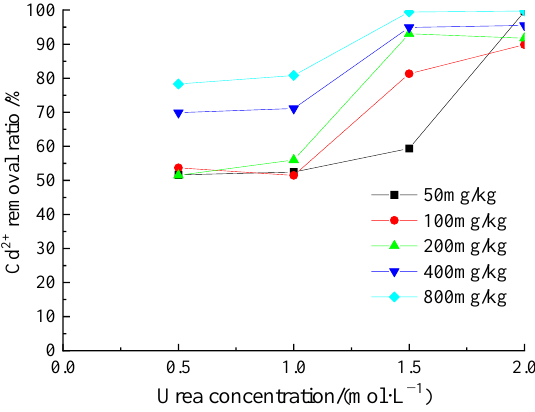
Figure 5. Removal ratio of Cd 2+ without Ca 2+.